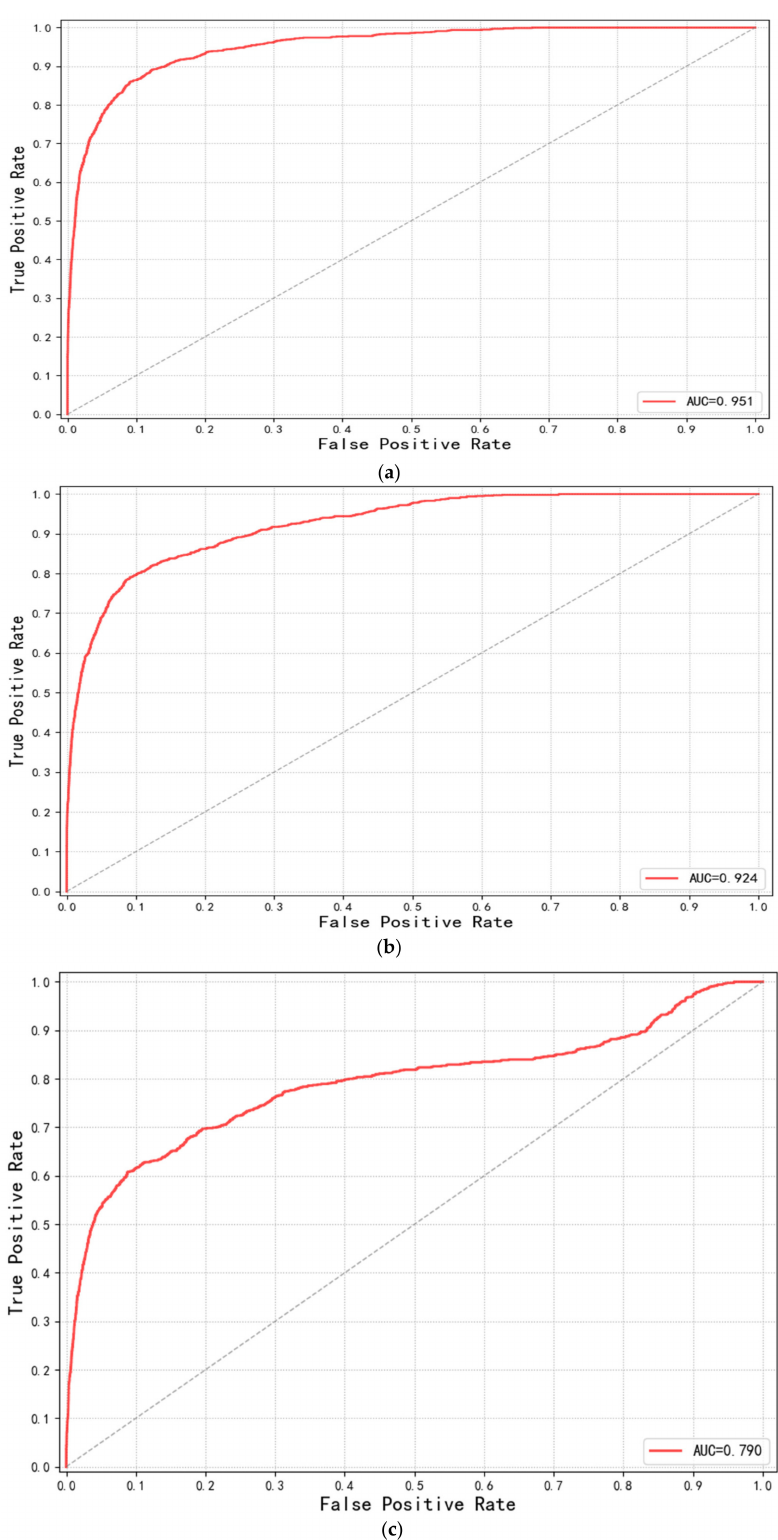
Figure 12. The receiver operating characteristic curves (ROC) and area under the curve (AUC) of the three different datasets in UC Merced Land-Use Dataset. ( a ) Datasets with fake samples generated by the improved SinGAN, ( b ) Datasets with true samples used for the training of the improved SinGAN, ( c ) Datasets with random samples randomly selected by the classifier